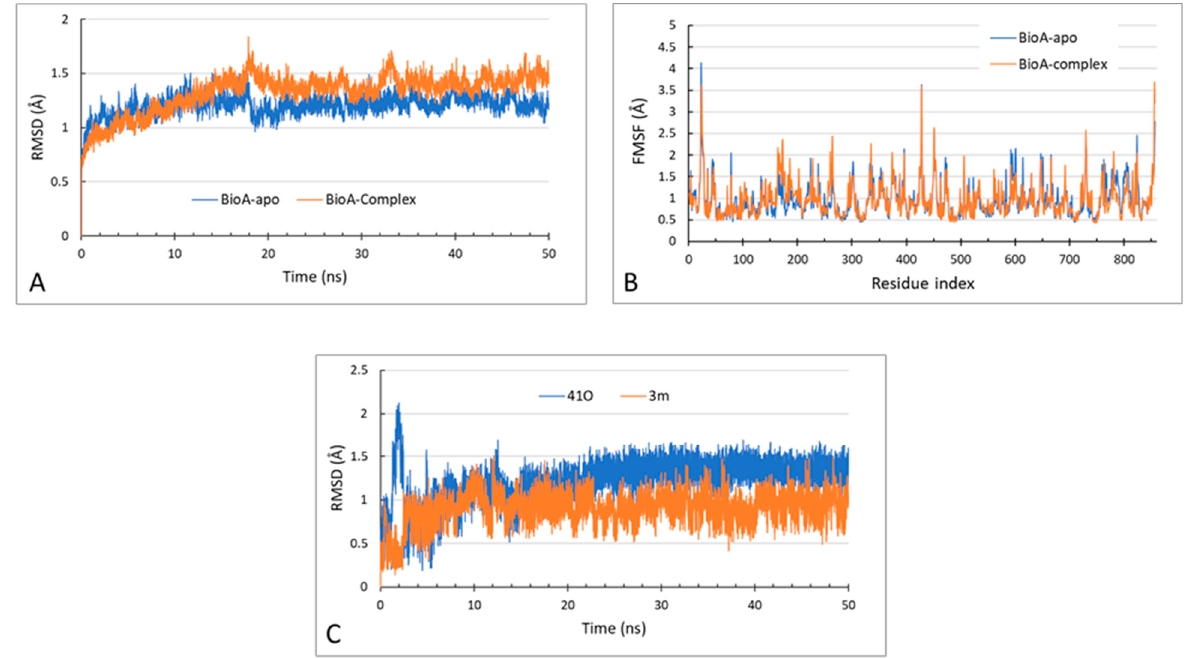
Figure 3. ( A , B ) are RMSD and RMSF plots for the simulated BioA- 3m complex compared to the apo form. ( C ). The RMSD plots for compound 3m compared to 41O as the simulated system evolved with time.